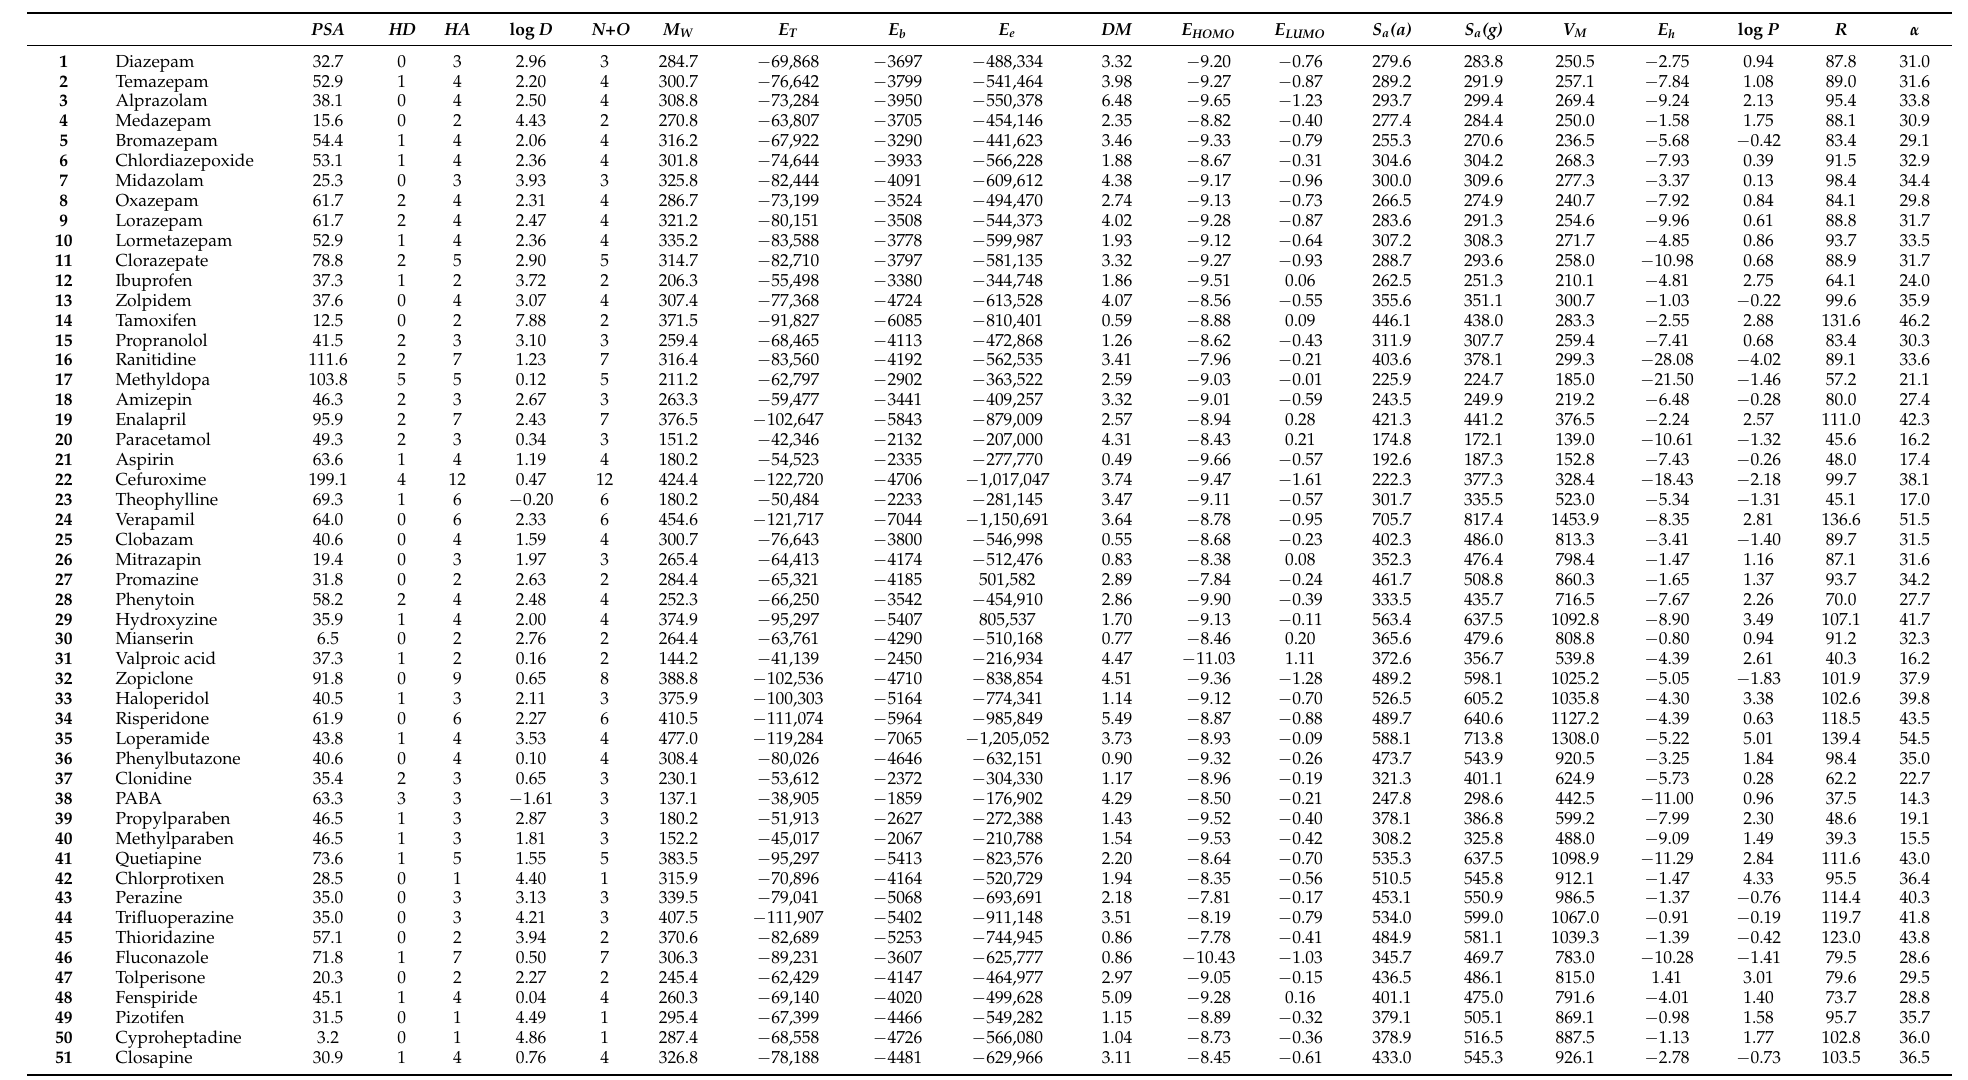
Table 5. Calculated descriptors for compounds 1 to 63